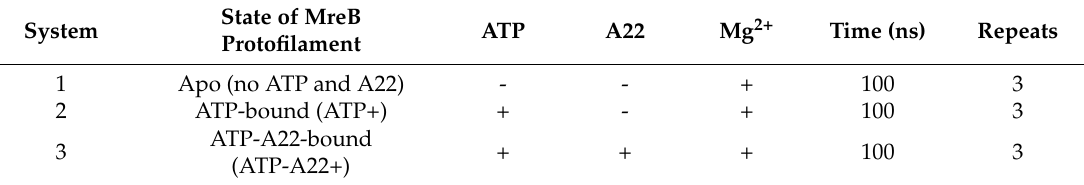
Table 1. Table summary of the molecular dynamics (MD) simulation